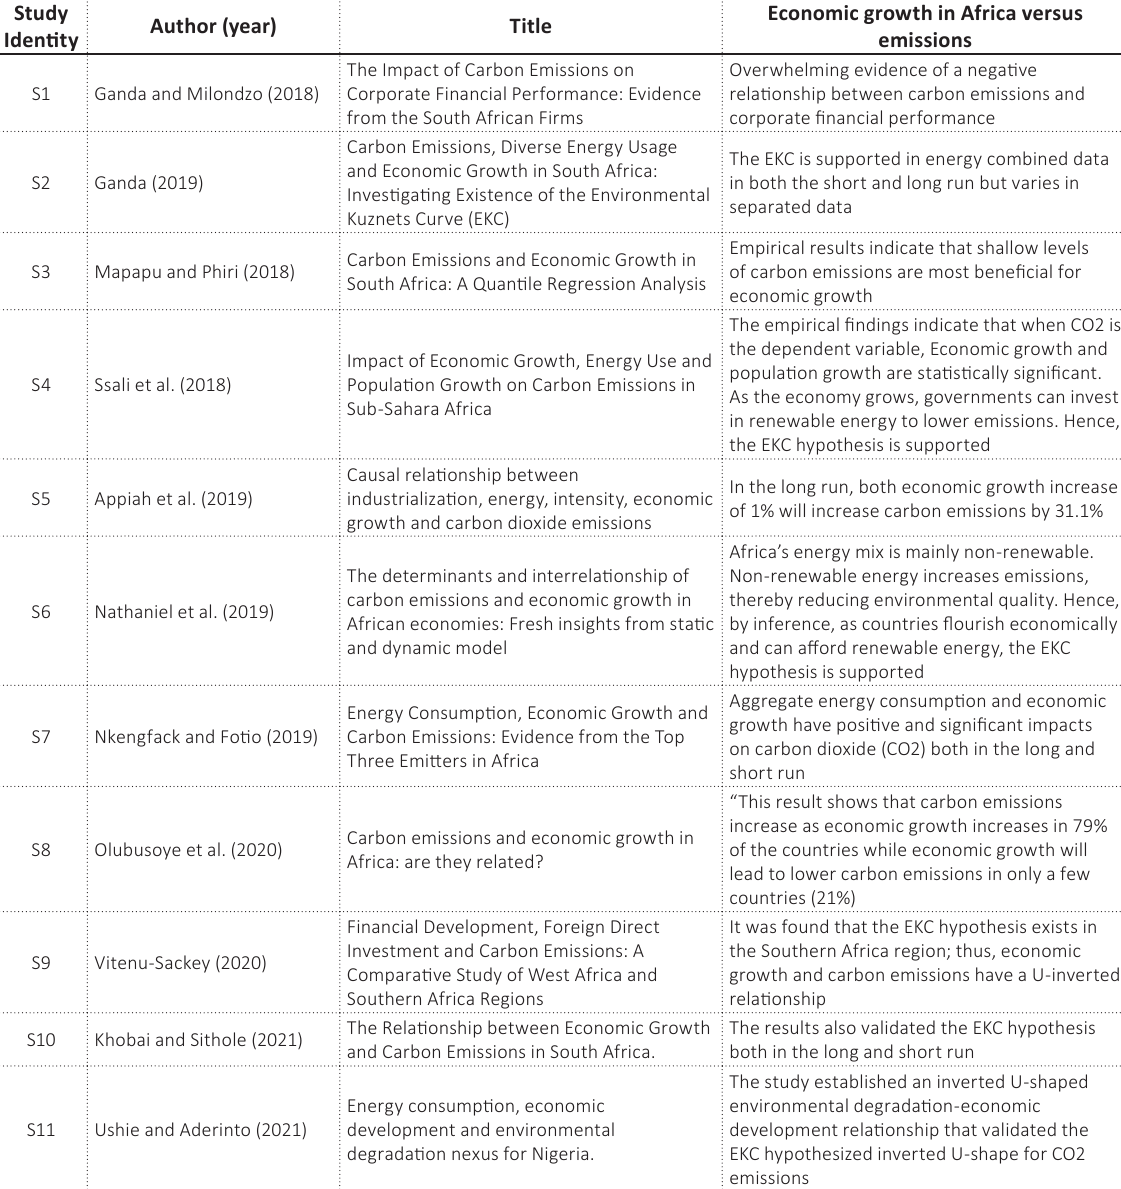
Table 1. Selected papers on the economic growth in Africa versus emissions